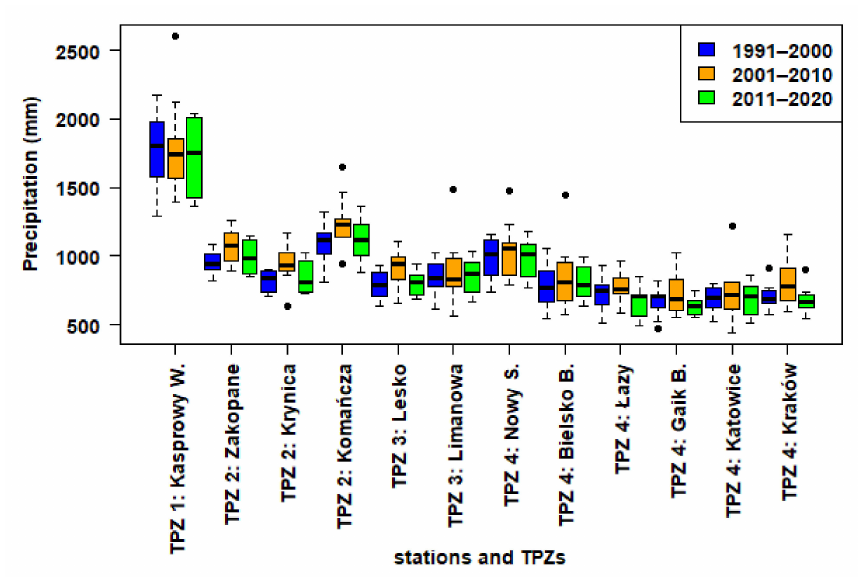
Figure 3. Mean annual total of precipitation (mm, black horizontal marks inside the boxes) in specific decades at the stations studied. Boxes mark the first and the third quartile, and the whiskers show the highest and the lowest value in a certain decade, except the outliers which are shown with black dots. Standard errors for the mean values are provided in Appendix C. Stations are ordered following the concept of TPZ explained in Section